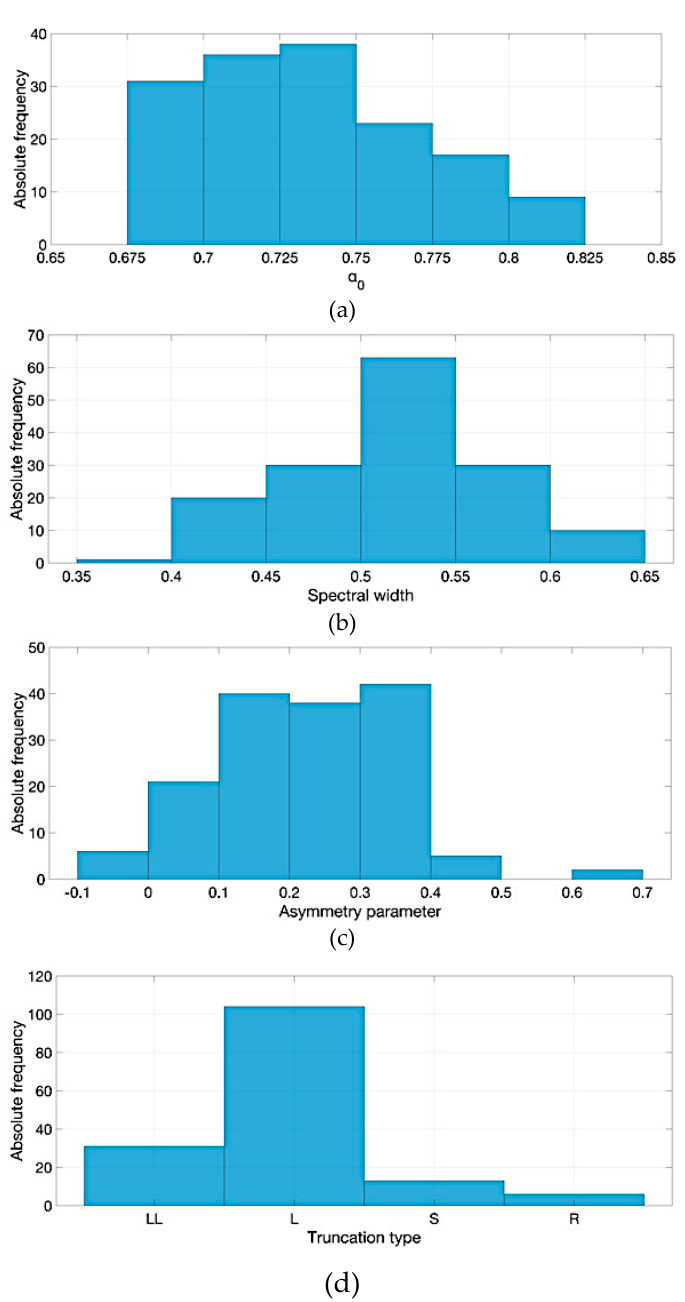
Figure 5. Multifractal spectral parameters distributions for a 0 ( a ), spectral width ( b ), asymmetry parameter ( c ), and truncation type ( d ).